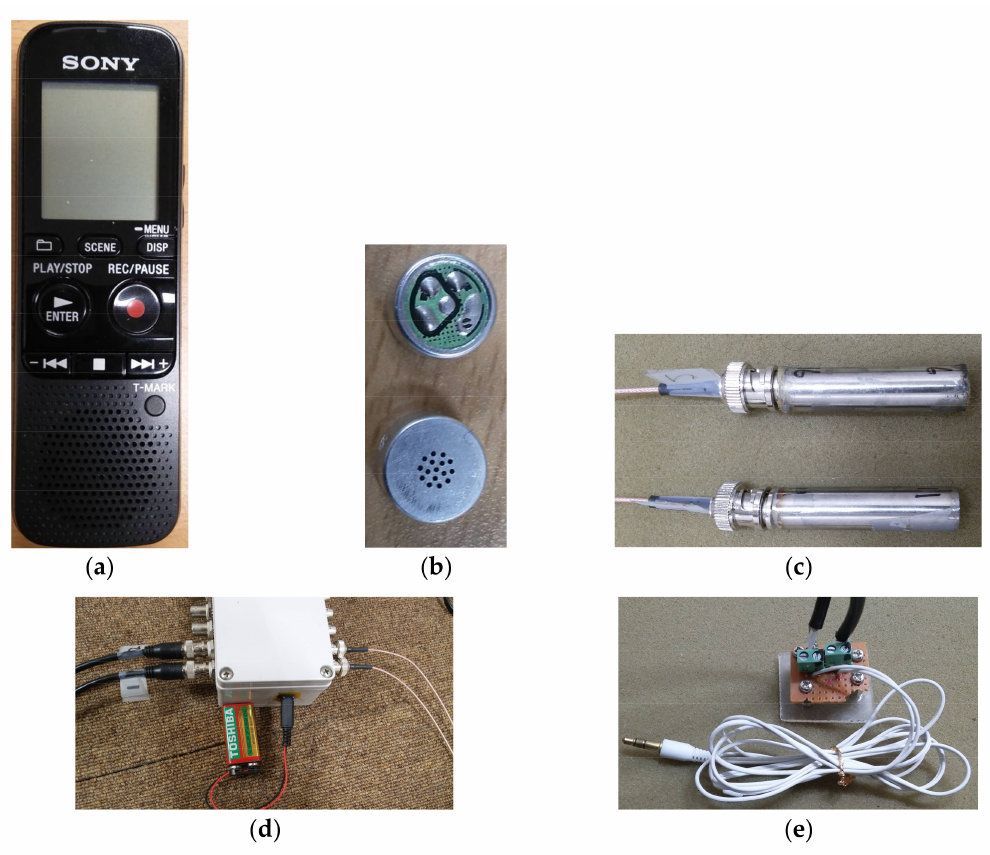
Figure 1. Digital recorder and microphones: ( a ) Digital recorder; ( b ) Electret condenser microphone capsules; ( c ) Electret condenser microphone capsules in tube ( d ) Electret condenser microphone power supply; ( e ) BNC to 3.5 mm plug